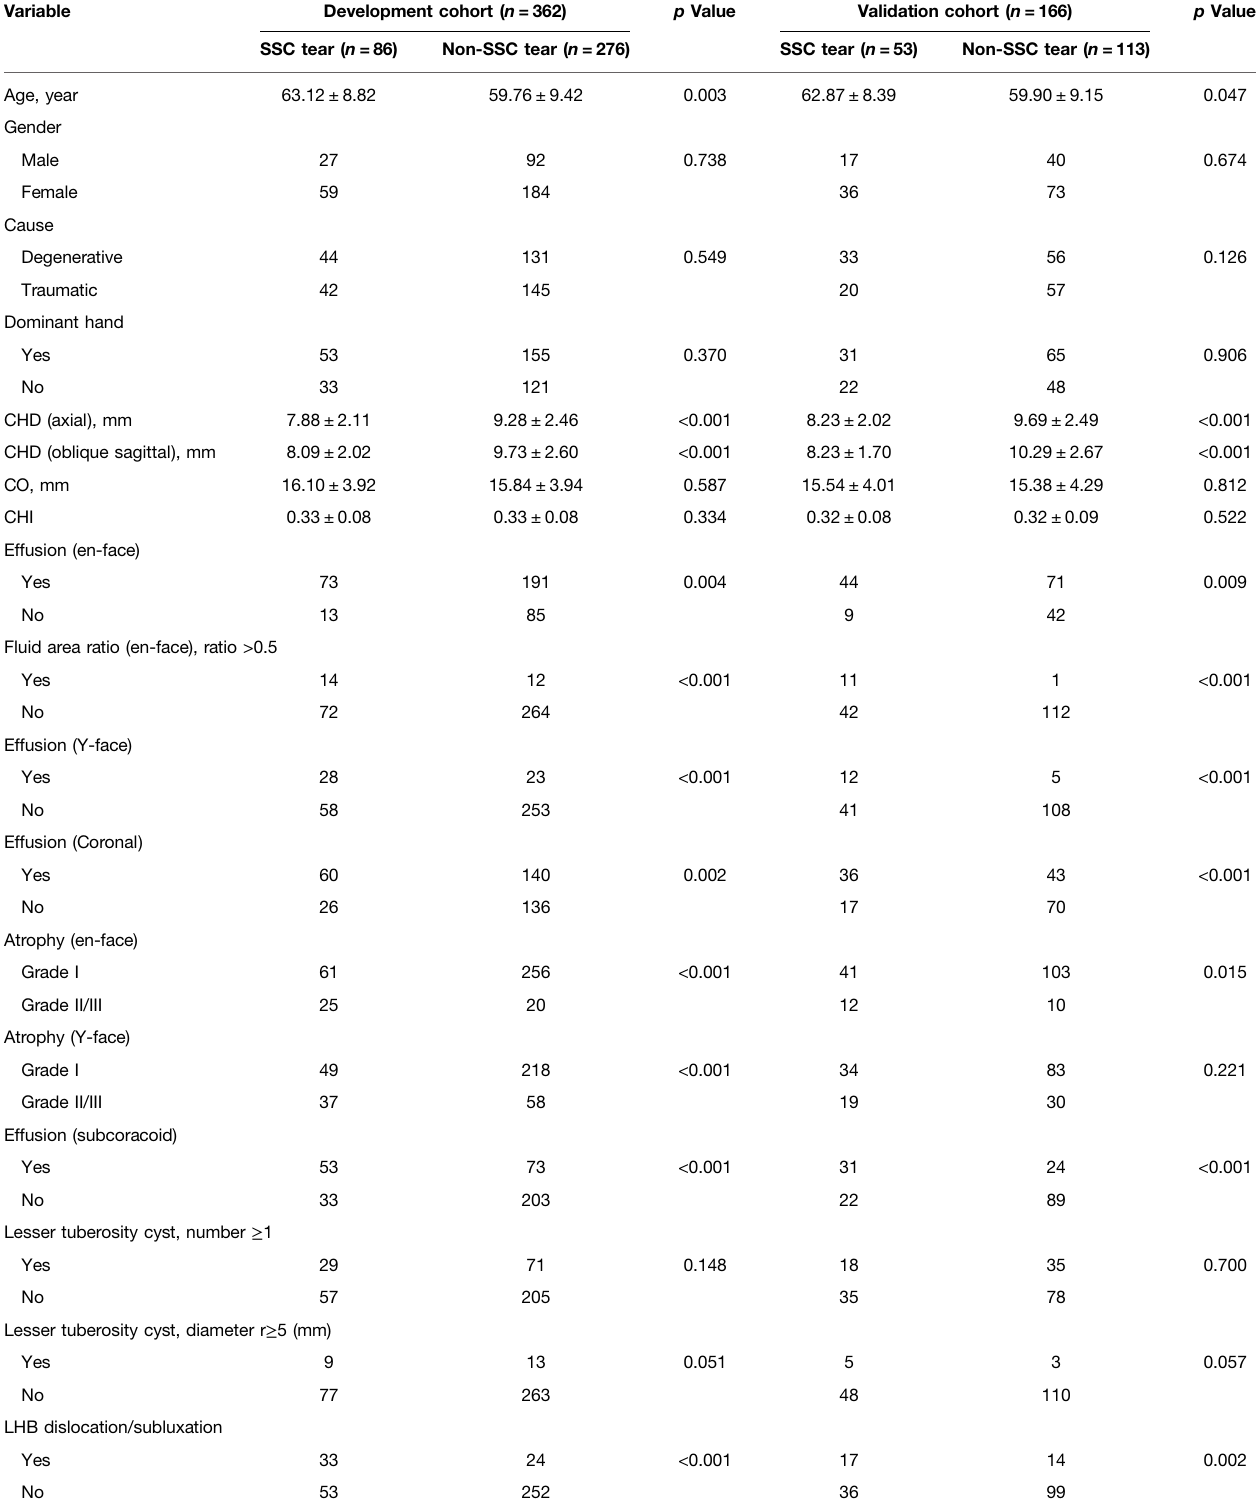
TABLE 1 | Clinical and imaging features of SSC tears in the development and validation